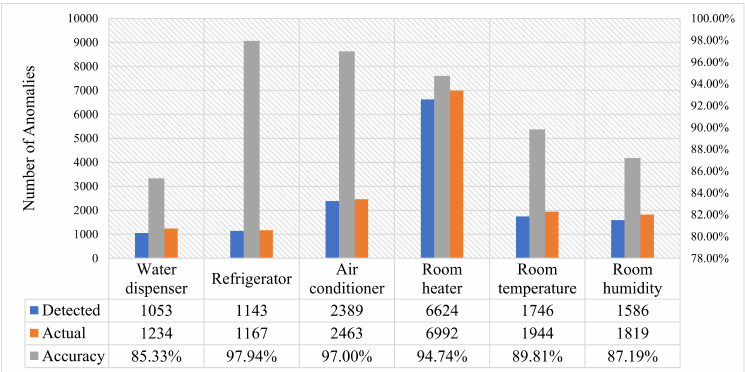
Figure 18. Performance analysis of the trained AI